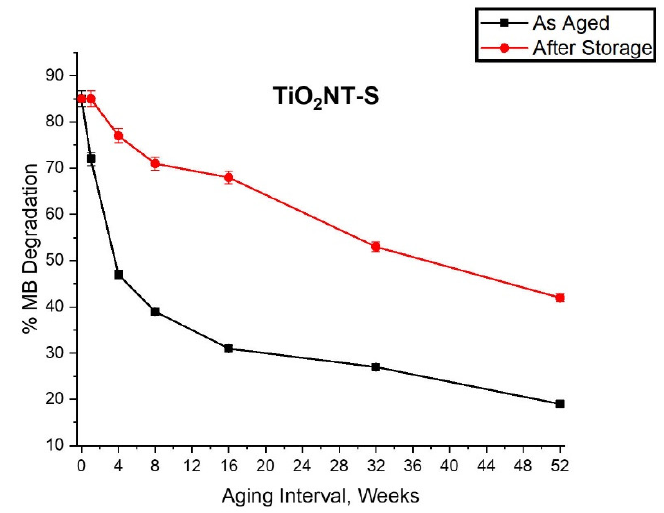
Figure 11. Change in Photocatalytic activity with sample aging duration.